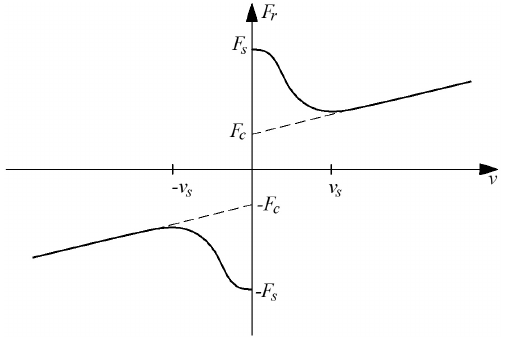
Figure 1. Steady-state friction